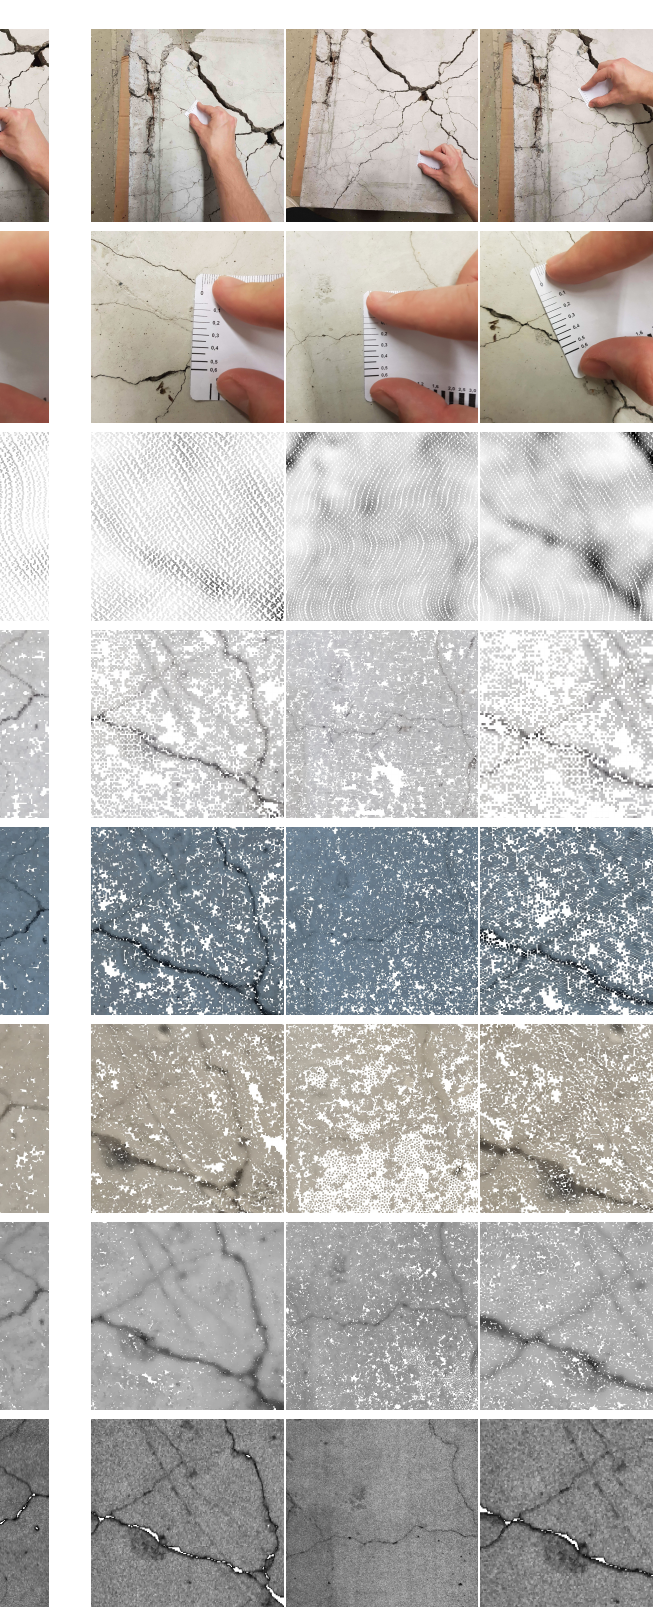
Figure 10. Comparison of intensity point clouds for three Figure 11. Comparison of intensity point clouds for three different cracks (columns) in the following order from top to different cracks (columns) in the following order from top to bottom: crack location, crack detail, PPS-Plus, S8, Fuji shadow, bottom: crack location, crack detail, PPS-Plus, S8, Fuji shadow, Fuji sun, G-419B, Ranger3. Fuji sun, G-419B,